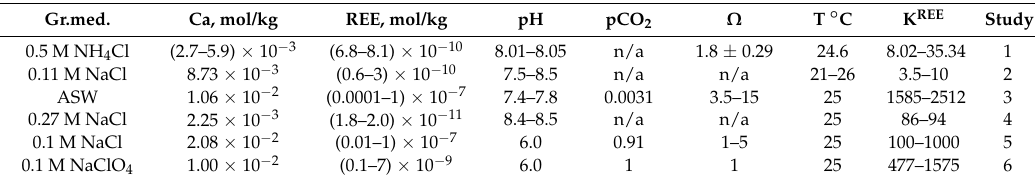
Table 3. Partitioning data from the literature and the experimental